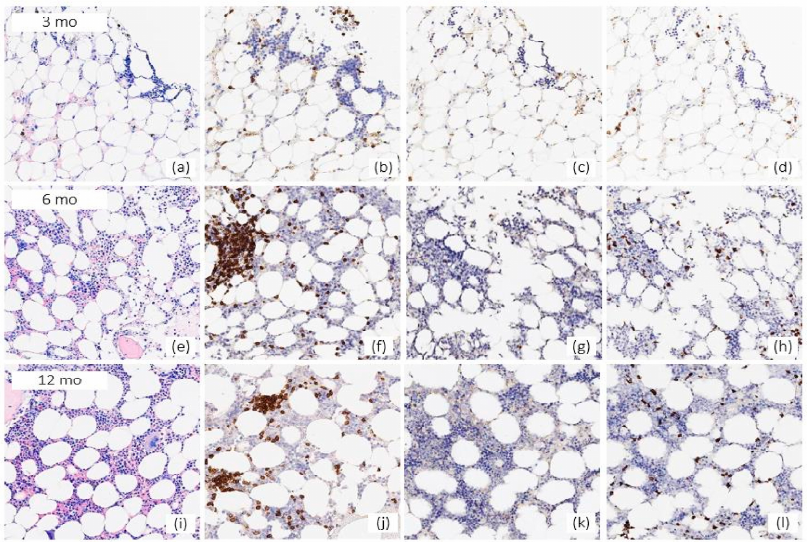
Figure 2. Bone marrow histology at 3, 6 and 12 months (mo) of eltrombopag treatment. The 3-months-biopsy ( a ) Giemsa, 200×, depicts a hypocellular bone marrow, with hematopoiesis mostly represented by erythroid islands, in the absence of remarkable features of morphologic dysplasia, nor increased blast count. An adjoining lymphoid population is very scant and mostly represented by small CD3+ T-cells; ( b ) CD3, 200×, interstitial in their distribution, with very rare CD4+ cells; ( c ) 200× and a minor component of CD8+ cells; ( d ) 200×, thus, consistent with the presence of a CD4-/CD8- subpopulation. The 6-months biopsy documents an increasing cellulari- ty, with relative over-representation of erythroid series; ( e ) Giemsa, 200×, coupled with a heavier T-cell infiltrate (10–15% of overall cellularity; ( f ) CD3, 200×, patterned in a micronodular and in- terstitial configuration, with no intrasinusoidal features, still partially lacking CD4; ( g ) 200× and CD8; ( h ) 200× expression. The 12-months biopsy displays a hematopoiesis within ranges; ( i ) Giemsa, 200x, notably featuring scattered giant, hyperlobated megakaryocytes (morphologic ap- pearance consistent with therapy related modifications) and a T-cell infiltrate; ( j ) CD3, 200×; ( k ) CD4, 200×; ( l ) CD8, 200× overlapping the previous picture. Grade of marrow fibrosis at 3, 6, and 12 months: MF-0. Not shown in the present panel, no significant amount of lymphoid cells are seen expressing CD56, CD57, TCR-delta, FoxP3, CD25, and TdT. Furthermore, focal, perivascular amy- loid deposits are observed, without evidence of residual plasma cell neoplasm component. 3.3. Cytokine Analysis Figure 3 shows the cytokine levels during eltrombopag treatment. The T helper1 (Th1) cytokines IFN- γ and TNF- α were at lower limit of normality of controls and re- mained stable along eltrombopag treatment. The T helper 2 (Th2) cytokines IL-6 and IL-10 levels and the immunoregulatory cytokine IL-17 were higher than in controls, and persisted elevated during therapy, with a peak of IL-6 levels at 12 months. Finally, the inhibitory cytokine TGF- β was progressively increased along eltrombopag treatment, although within the normal range.